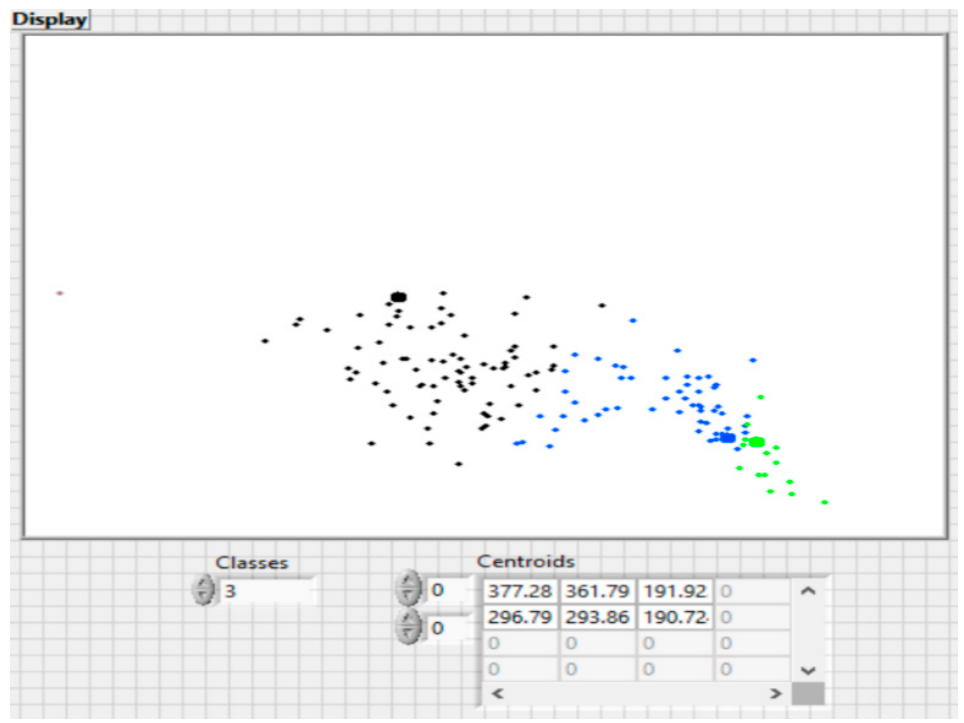
Figure 20. The results of the proposed k-mean algorithm for 3 classes.